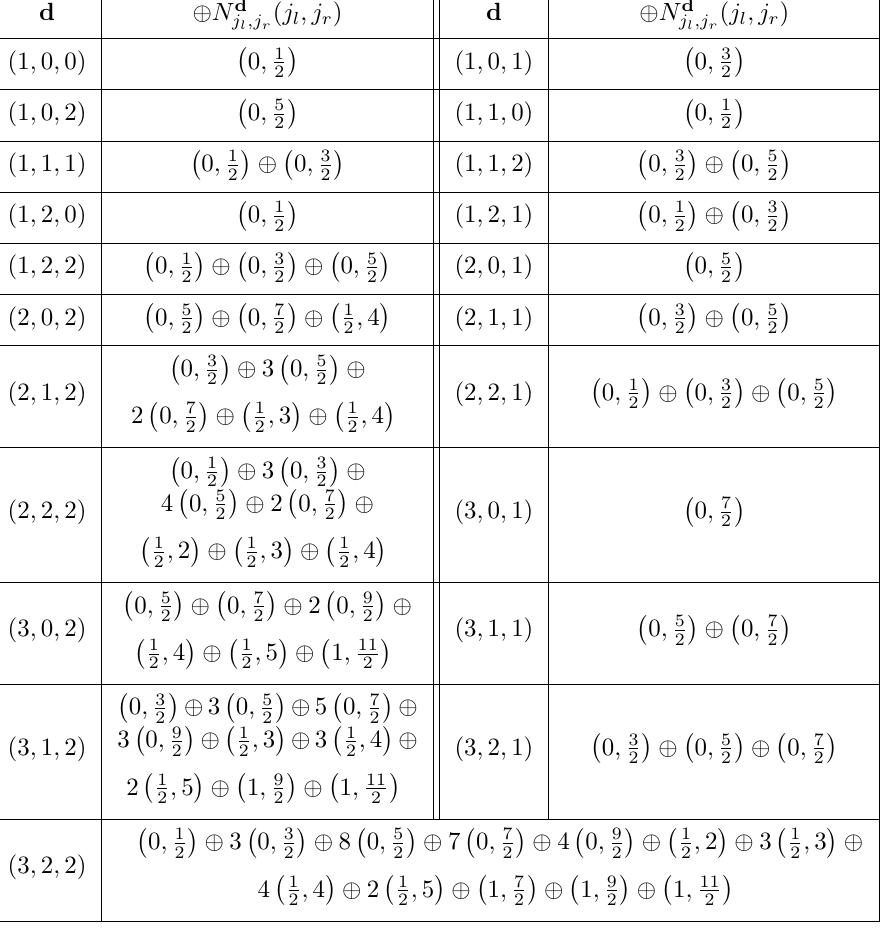
Table 8. BPS spectrum of the SU(3) 7 theory for d 1 ≤ 3 and d 2 , d 3 ≤ 2 . Here, d = ( d 1 , d 2 , d 3 ) labels the BPS states with charge d 1 e 2 + d 2 f 1 + d 3 f 2